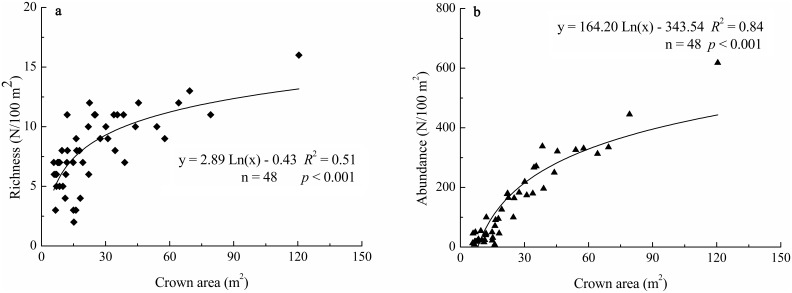
Logarithmic regression of P. euphratica crown areas against species abundance and richness.In regression line (Fig. 3a), each point indicating the richness of all species (no including P. euphratica) under the P. euphratica canopy. In regression line (Fig. 3b), each point indicating the abundance of all species (no including P. euphratica) under the P. euphratica canopy. The crown area of each sample is the sum of P. euphratica individuals.